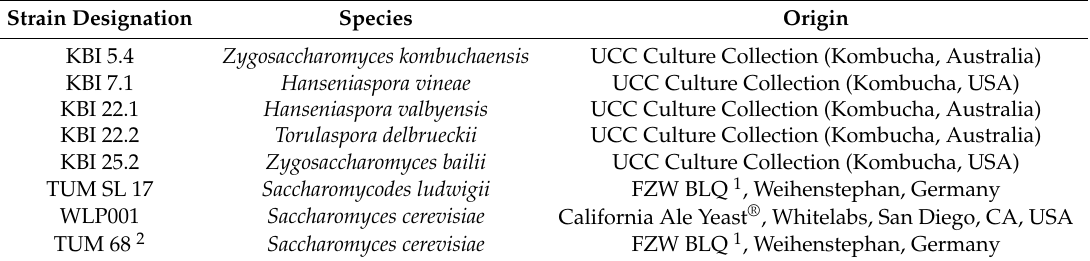
Table 1. Yeast strain designation, species and origin of yeast strains used in this